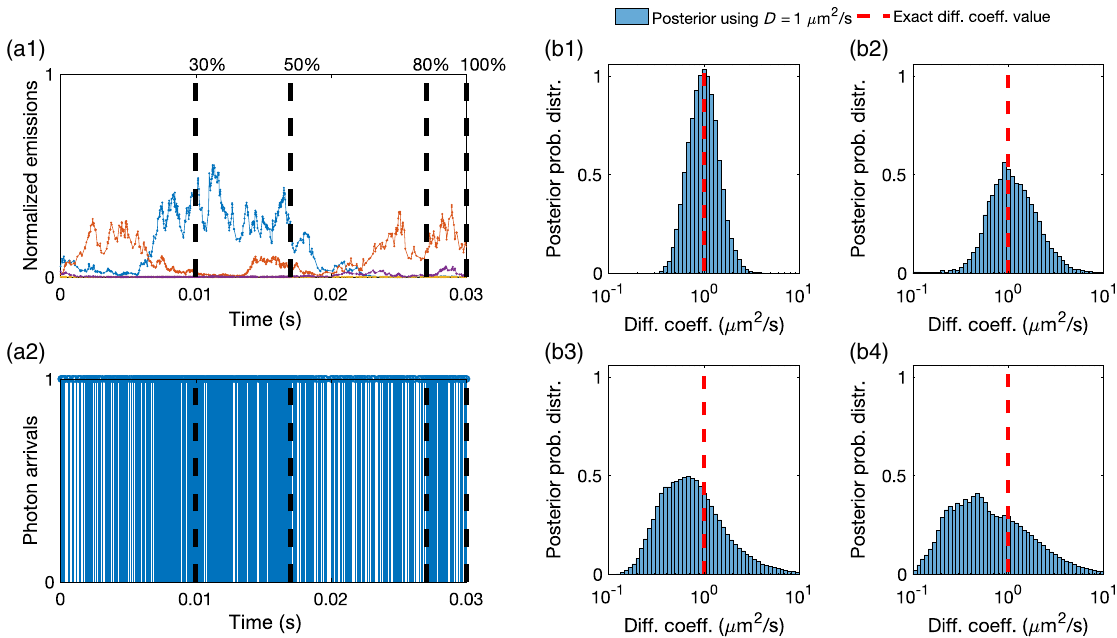
FIG. 4. A higher number of total photon arrivals provide more photons per unit time and sharper diffusion-coefficient estimates. (a1) Instantaneous molecule photon emission rates μ n , normalized by μ . (a2) Photon arrival trace resulting from combining photon mol k emissions from every molecule and the background. This synthetic trace contains ≈ 2000 photon arrivals produced by four molecules diffusing at 1 μ m 2 = s for a total time of 30 ms under background and molecule photon emission rates of 10 3 photons = s and 4 × 10 4 photons = s, respectively. The dashed lines show the initial 30%, 50%, 80%, and 100% portions of the original trace containing ≈ 600 , ≈ 1000 , ≈ 1600 , ≈ 2000 photon arrivals, respectively. (b1) – (b4) Posterior probability distributions drawn from traces with differing length [shown in (a2)]. As expected, for the longer traces, the peak of the posterior matches with the exact value of D (dashed line). Gradually, as we decrease the total number of photon arrivals analyzed, the estimation becomes less